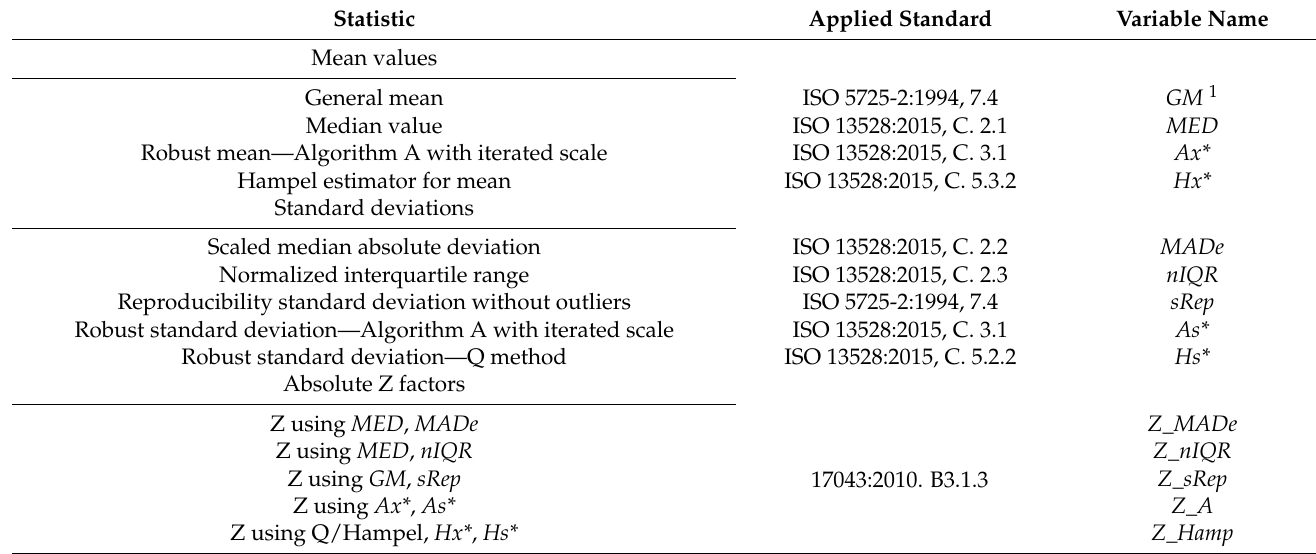
Table 2. Classical and robust